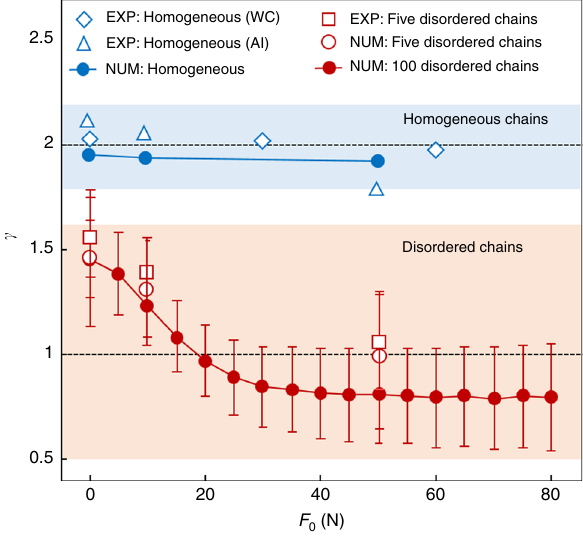
Fig. 5 Energy-spreading characteristics. Exponents ( γ ) of the second moment m 2 of kinetic energy as a function of precompression strength. The exponents 1 and 2 (horizontal dashed lines) represent diffusive and ballistic transport, respectively. The diamond, triangular, and square marks are based on experimental data obtained, respectively, from a homogeneous tungsten-carbide (WC) chain, a homogeneous aluminum (Al) chain, and a mean over fi ve disordered chains. (See Supplementary Table 1 and Supplementary Note 1 for details about the fi ve disordered chains.) We mark the numerical data with circles. We do computations for homogeneous chains (blue circles), the fi ve disordered chains (hollow red circles), and 100 randomly generated disordered chains (red circles with error bars). The red circles and error bars, respectively, give the mean values and standard deviations of the computed exponents from the 100 cases precompression F 0 , in line with our numerical observations (white circles). However, while our experimental fi ndings de fi nitively manifest superdiffusion, they are inconclusive about the potential transition to subdiffusion as one increases F 0 .